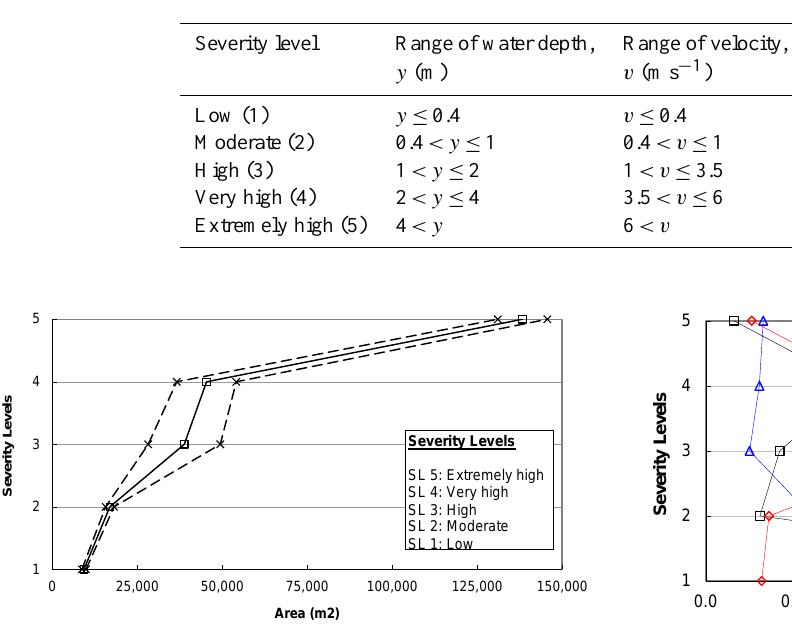
Fig. 22. 2-D SWE model. Expected values and standard deviations of the extension of areas with different severity levels for flow case 500m 3 s − 1 .